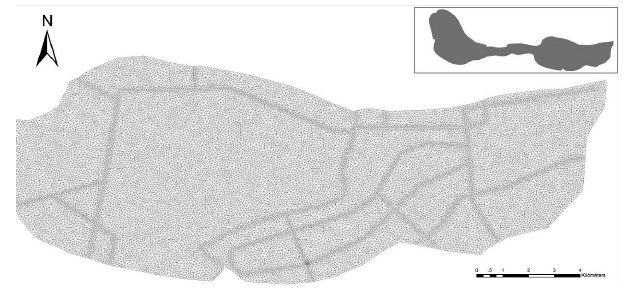
Figure 4. The two-dimensional (2-D) hydraulic model mesh of the Gongshuangcha detention basin and its regional enlarged